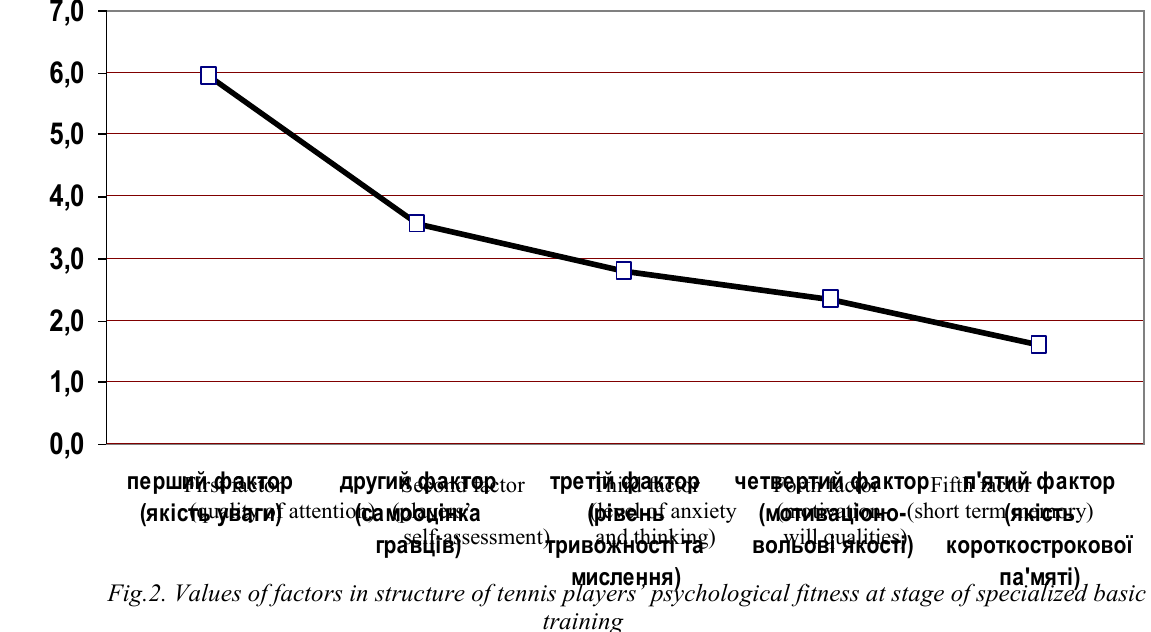
Fig.2. Values of factors in structure of tennis players’ psychological fitness at stage of specialized basic